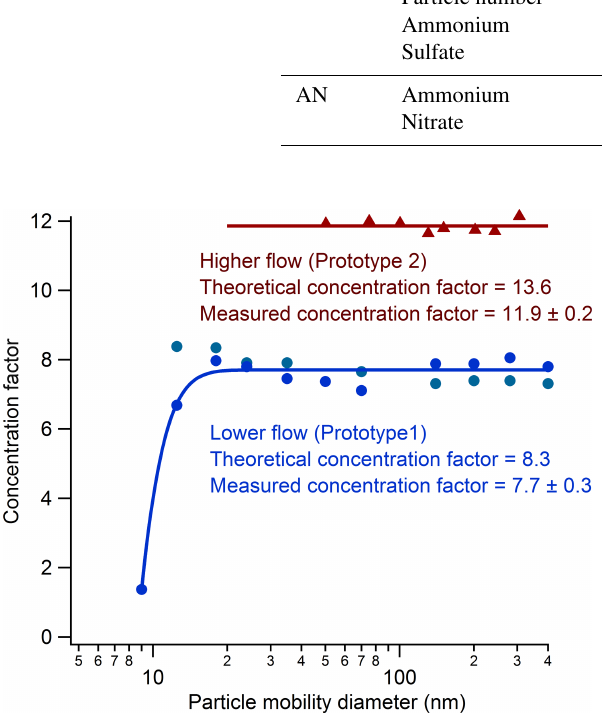
Figure 2. Size-dependent concentration factor for the ADIc for higher (triangles) and lower (circles) flow regimes as a function of particle size. The red line indicates the average of the higher flow data. The blue line is a guide for the eye. Data are from two different prototype instruments, as